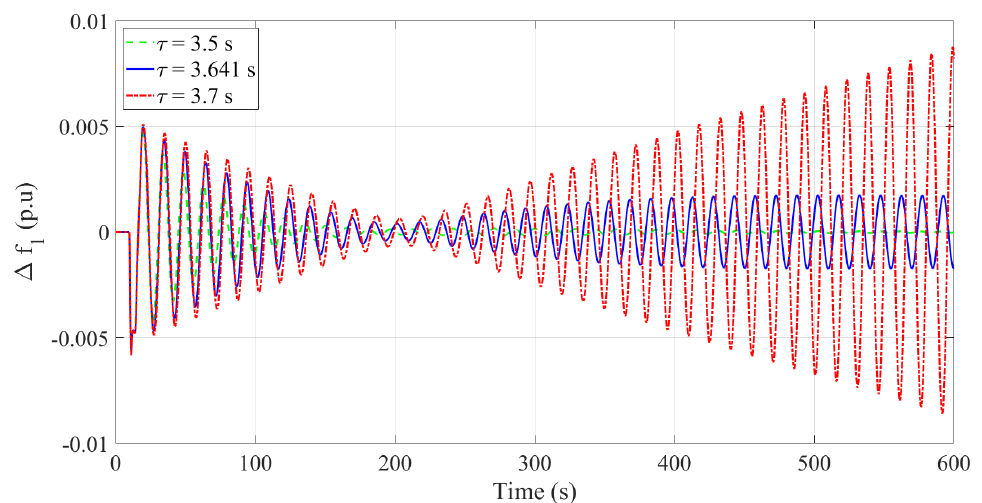
Figure 10. Frequency deviation for LFC − 1: ∆ f 1 was measured while using K P = 0.2 and K I =